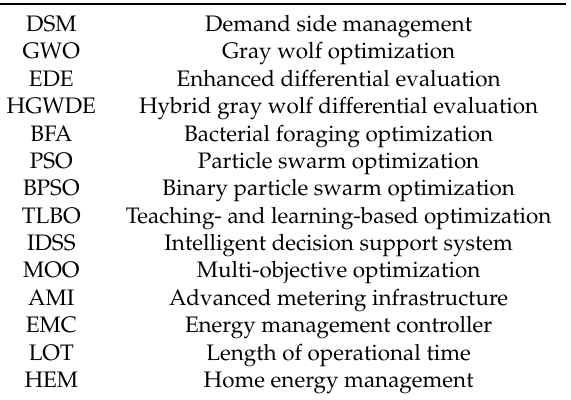
Table 1. List of